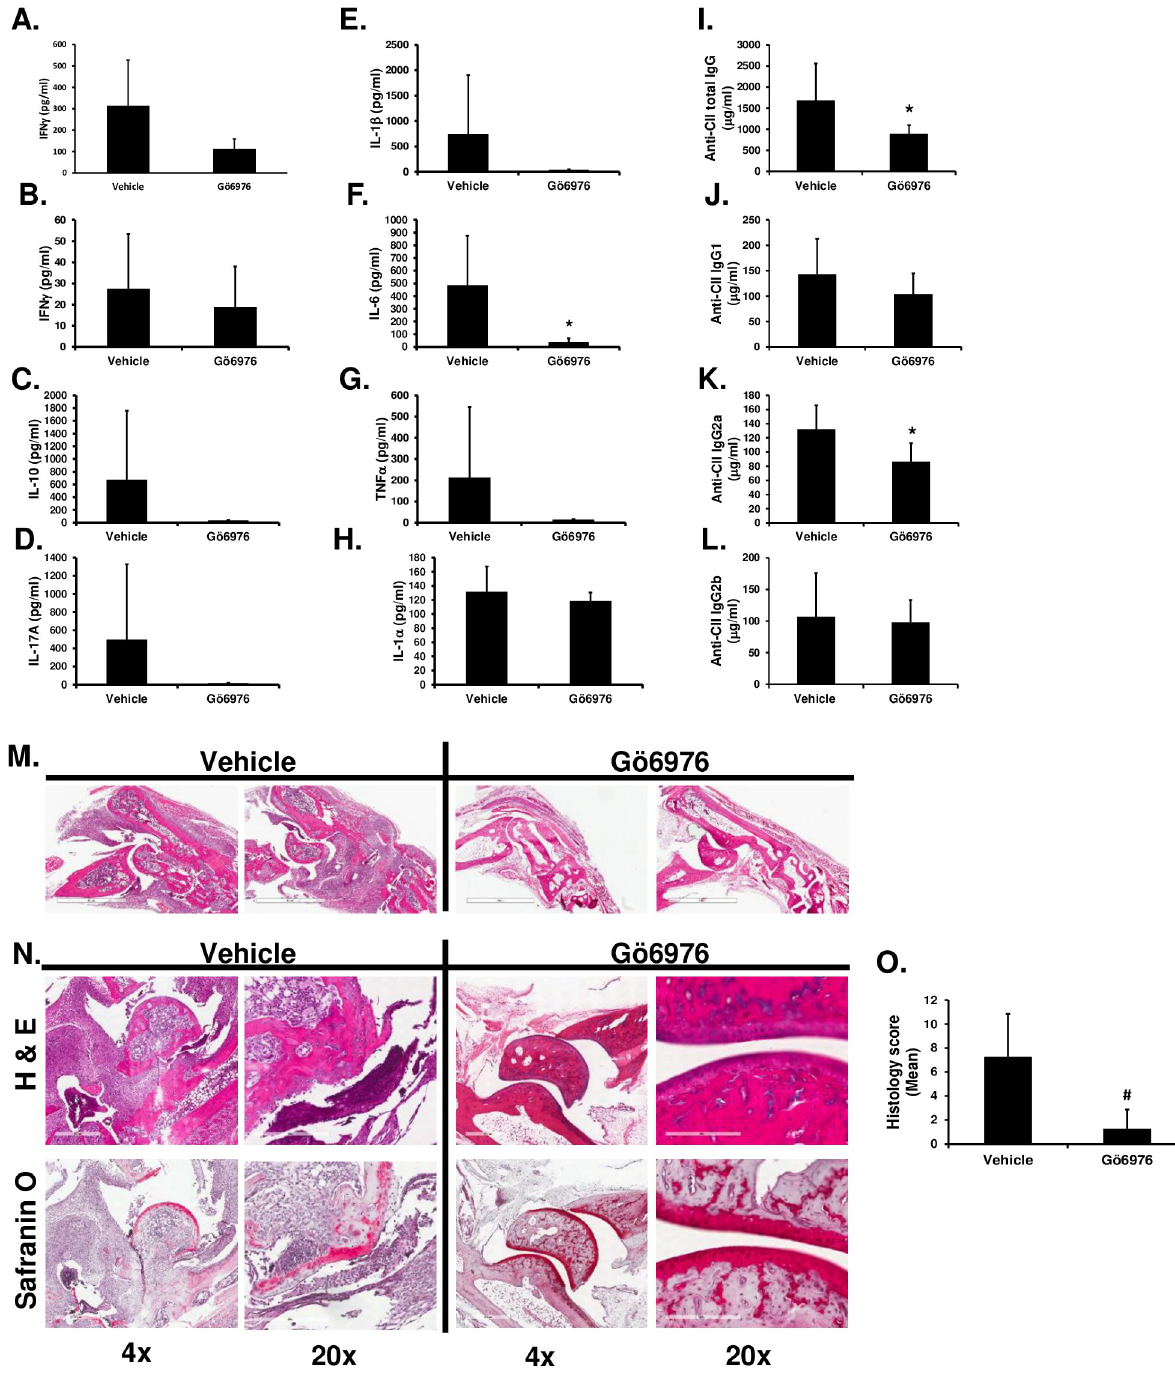
Fig 3. Effects of Go¨6976 treatments on the anti-CII IgG antibody production, joint inflammation and bone destruction in HLA-DR1 mice immunized with CII. HLA-DR1 mice were immunized with bovine CII and treated daily with vehicle (n = 4) or Go¨6976 (n = 5) for 34 days starting at the day of CII immunization. Blood (at day 11 and day 35) and joints (at day 35) were harvested. (A—H) Levels of the selected cytokines in serum isolated at day 11 (A) and at day 35 (B—H) were analyzed by multiplex sandwich immunoassay. Data represent the mean concentration (pg/ml) ± SD. � , p < 0.05. (I–L) Levels of total anti-CII IgG antibodies (I), anti-CII IgG1 antibodies (J), anti-CII IgG2a antibodies (K) and anti-CII IgG2b antibodies (L) in serum isolated at day 35 were analyzed by isotype-specific anti-CII IgG ELISA. Data represent the mean concentration ( μ g/ml) ± SD. � , p < 0.05. (M) Representative H&E stained joint tissue section (1.5 x of the original objective; white scale bar = 2 mm). (N) Representative H&E (top) or safranin O (bottom) stained joint tissue sections. White scale bar = 600 μ m at 4 x of the original objective. White scale bar = 200 μ m at 20 x of the original objective. (O) Histology score (vehicle: n = 8 paws, Go¨6976: n = 10 paws). Data represent the mean ± SD. #, p < 0.0005. Experiments were repeated two to four times with similar results.